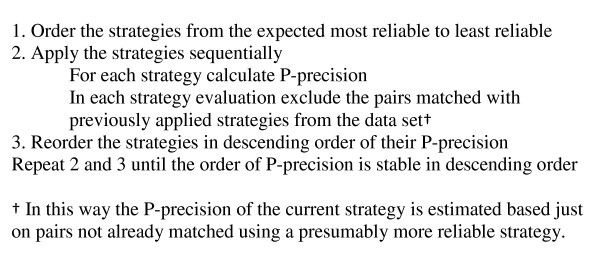
Strategy ordering.